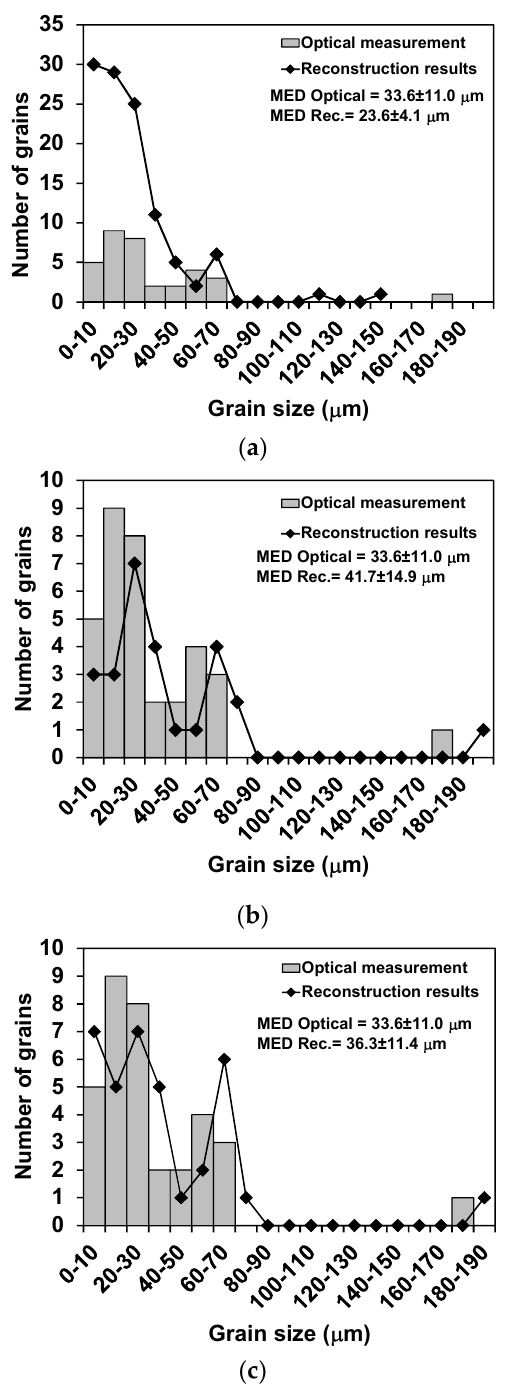
Figure 11 . Comparison of the MED (Mean Equivalent Diameter) measurements obtained from Figure 11. Comparison of the MED (Mean Equivalent Diameter) measurements obtained from conventional metallography and the reconstruction procedure for the 0.5 μm step size scan using different conventional metallography and the reconstruction procedure for the 0.5 µ m step size scan using criteria for twin boundary definition (4 μm minimum grain size): ( a ) All high angle (>10°) grain boundaries different criteria for twin boundary definition (4 µ m minimum grain size): ( a ) All high angle (>10 ◦ ) grain boundaries considered; ( b ) twins excluded (misorientation criterion (5 ◦ tolerance)); and ( c ) twins excluded (misorientation criterion (5 ◦ tolerance) + {111} plane coincidence criterion (1 ◦ tolerance